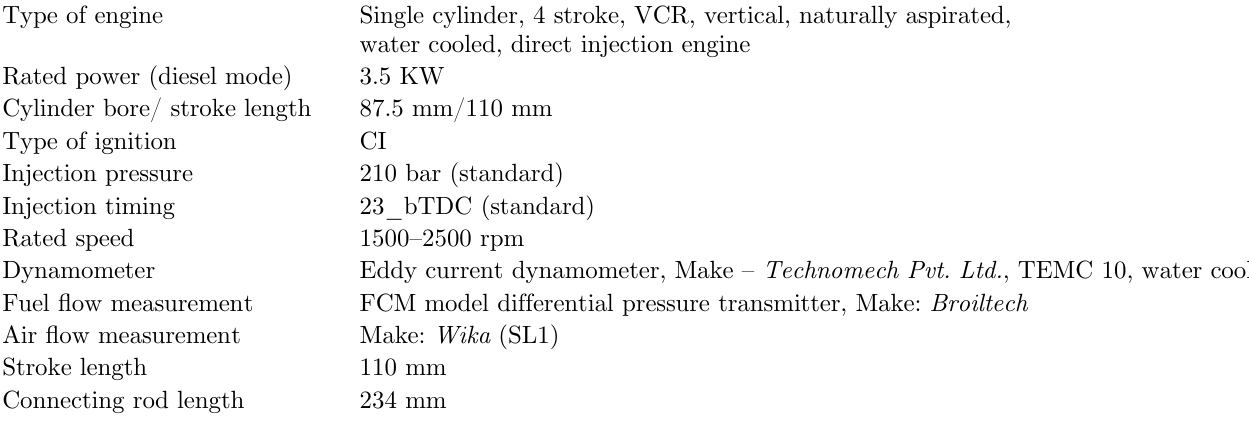
Table 2. Test engine speci fi